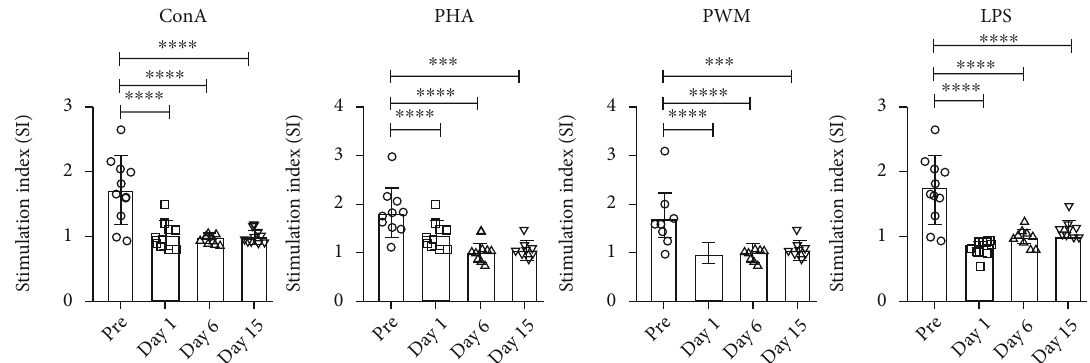
Figure 4: Proliferative response of PBMCs to mitogens. PBMCs that are isolated from blood samples of the squirrel monkeys were used for determining proliferative response to di ff erent mitogens, using the MTT assay. The proliferation responses are expressed as stimulation index (SI) after blank (i.e., medium only) subtraction. p values were considered statistically signi fi cant at p < 0 : 05 .